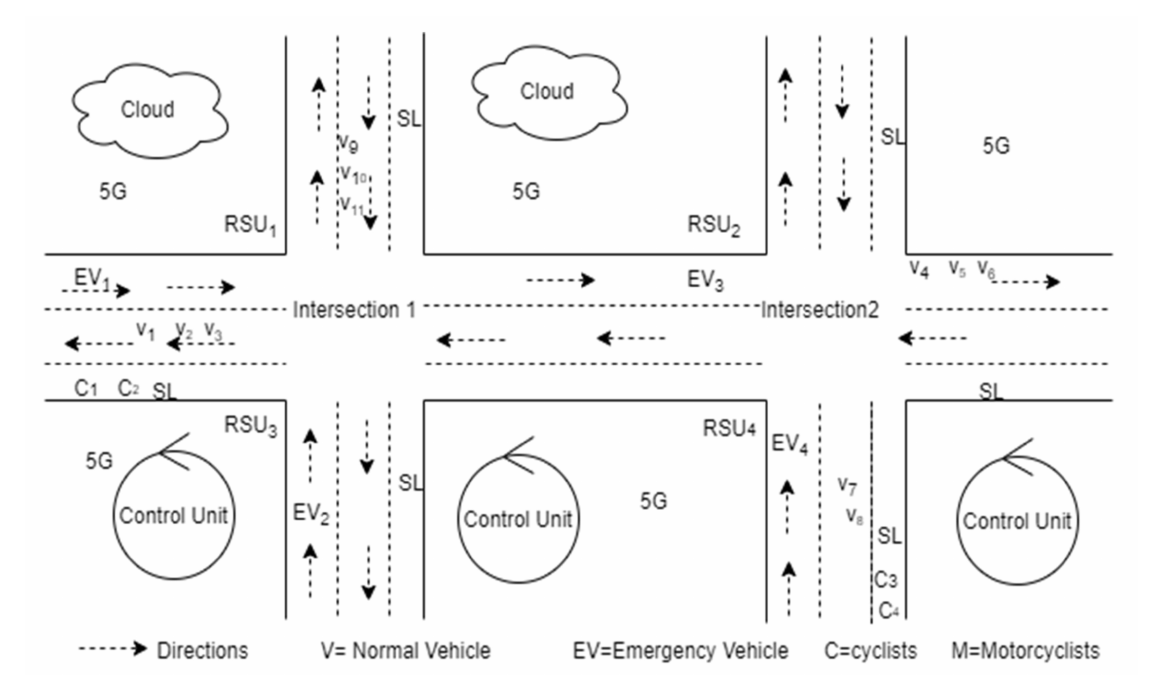
Figure 2. An overview of